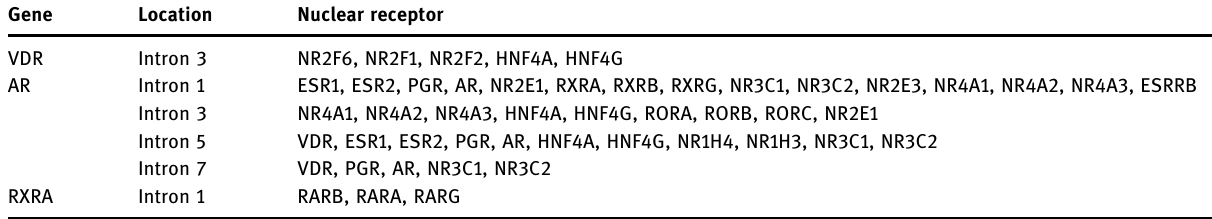
Table 2: Nuclear receptor - binding domains detected in the intronic conserved sequences of three NR genes involved in prostate cancer etiology Gene Location